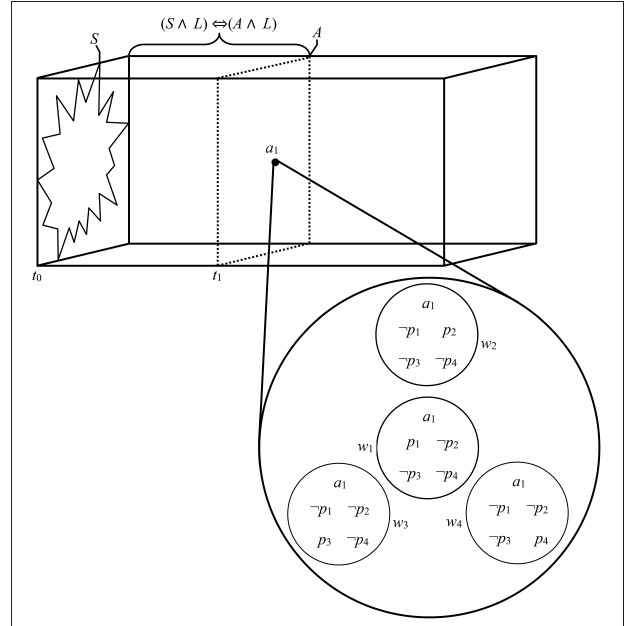
FIGURE 1 | Bubbled Block Universe, where S is the complete set of initial conditions (the low-entropy Big Bang) at the time-coordinate t 0 , L is the complete set of all the fundamental laws of physics, A is a complete state of spacetime at the time-coordinate t 1 , and a 1 is a specific action performed at t 1 . The action a 1 is a macrophysical event, and there is therefore a set of equiprobable (mutually exclusive) microphysical states ( p 1 – p 4 ) that are consistent with the occurrence of a 1 . Supposing that w 1 represents the actual circumstances (that a 1 occurs and is realized by p 1 ), the subsystems w 2 – w 4 represent the possible, non-actual alternatives to w 1 . In other words, from the perspective of a 1 each of the systems w 1 – w 4 are equally possible. (Figure not to